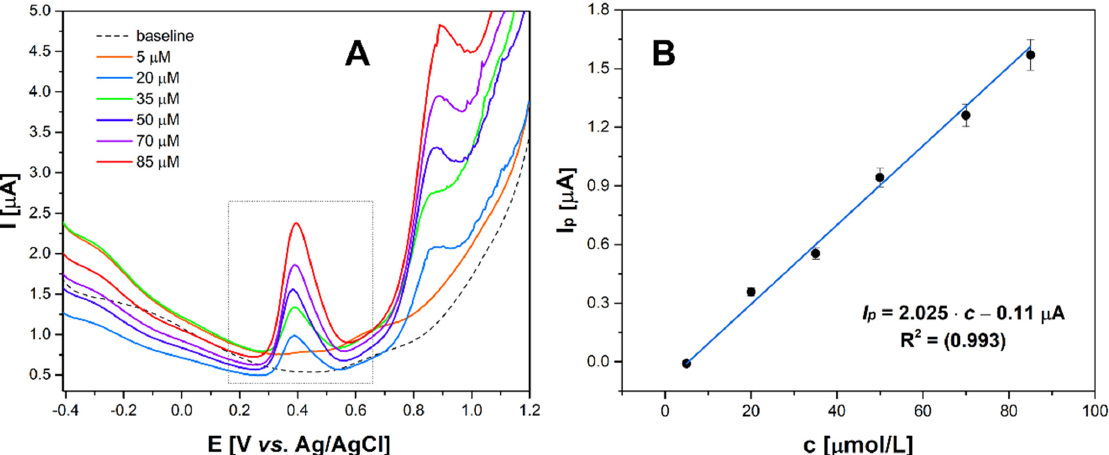
Table 1. Comparison of proposed method parameters with literature